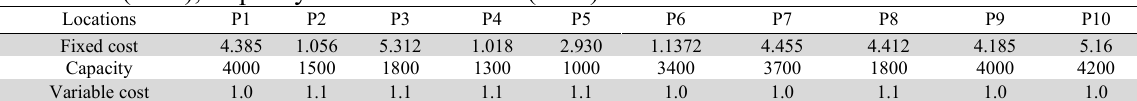
Table 1 Fixed Cost (×10 7 ), Capacity and Variable Cost (×10 6 ) Locations